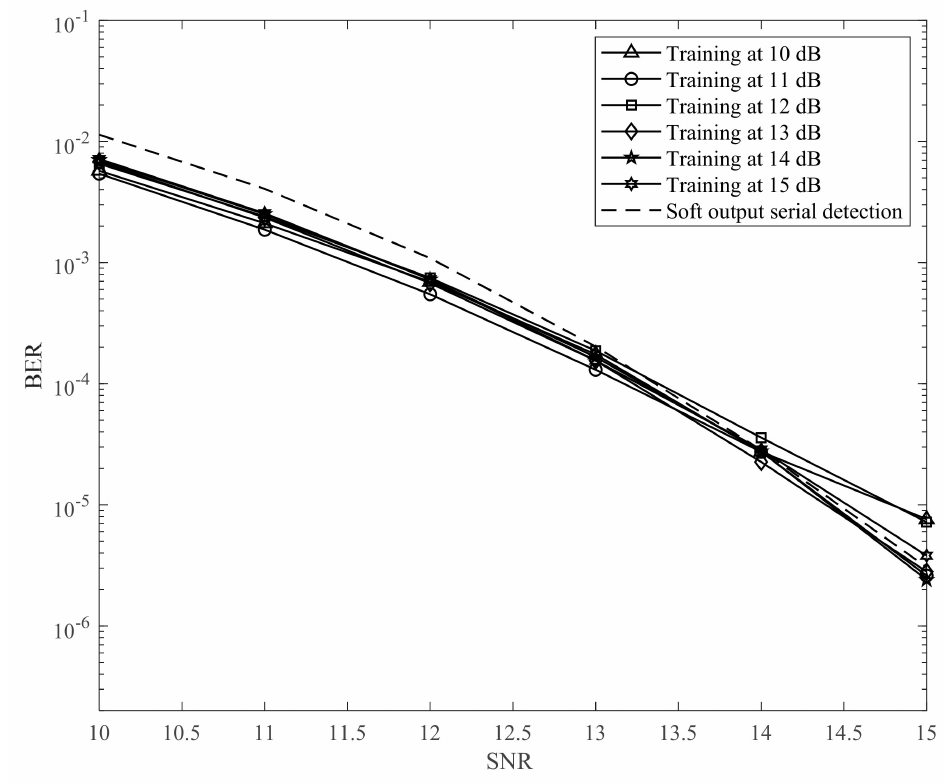
Figure 12. The BER performance of serial detection with three hidden layers neural network.